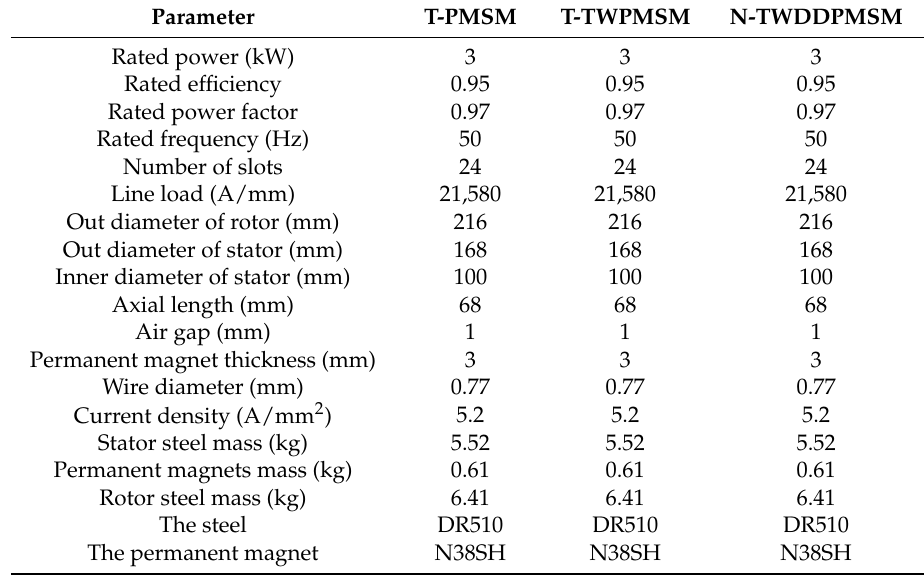
Table 5. Primary parameters of the proposed motor.